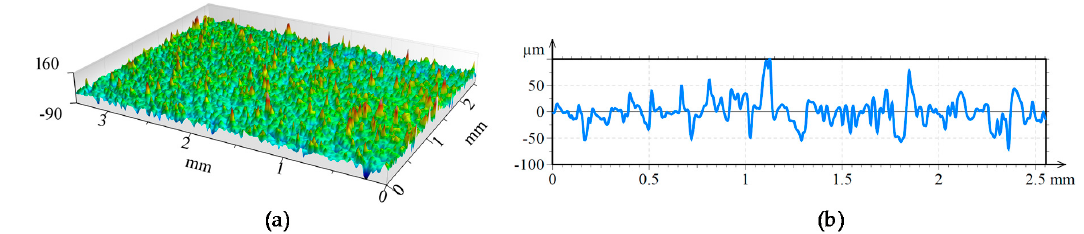
Figure 10. ( a ) Topography and ( b ) surface profile LMD + LBM.